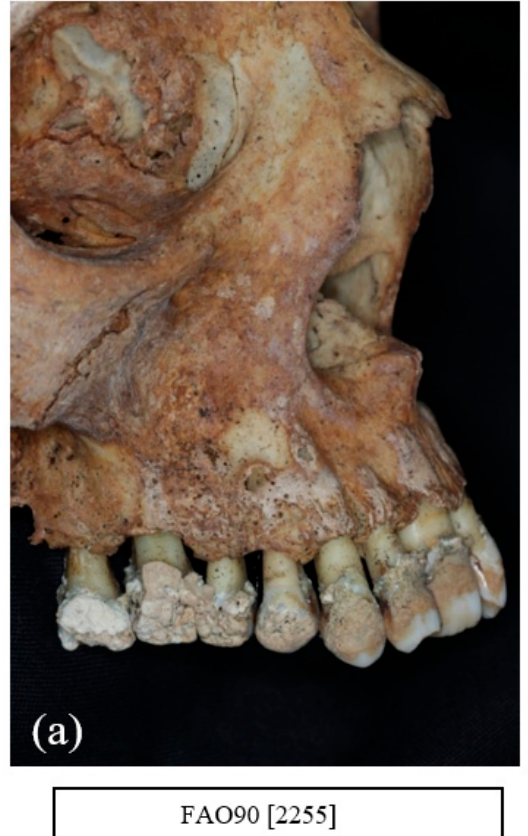
Figure 5. ( a ) FAO90 [2255] Female of age group 36–45 years with extensive deposit of supra gingival calculus covering the crowns of the upper maxillary teeth and ( b ) FAO90 [2255] Occlusal view of the same individual with evidence of occlusal calculus in the upper right quadrant. The right second molar (UR7) shows a gross carious lesion with pulp exposure (courtesy of the Museum of London).